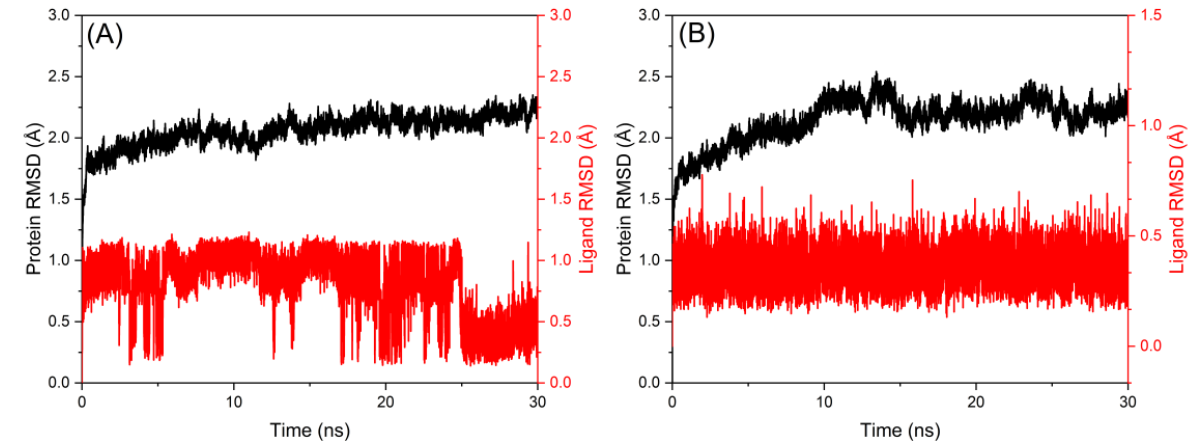
Figure 8. RMSD versus time for the PK-MYR complex ( A ) and PK-MYT ( B ) complex. RMSD for the heavy atoms of PK is shown in black. RMSD for the heavy atoms of MYR ( A ) and MYT ( B ) is shown in red.